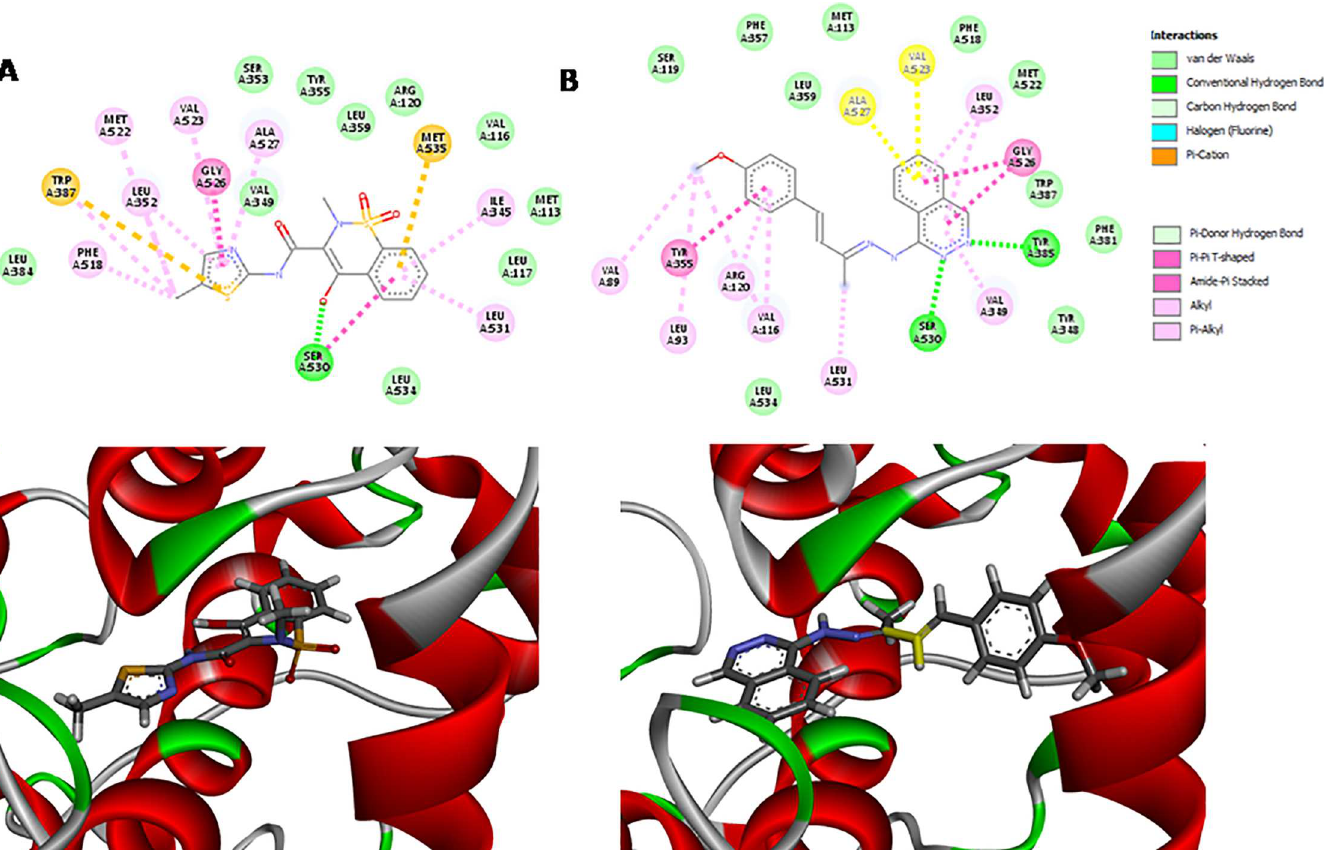
Fig 15. Results of the docking procedures for H5 and Meloxicam, (A) Interaction profile of H5 in the murine COX-2 enzyme binding site after the docking study; (B) Interaction profile Meloxicam in the murine COX-2 enzyme binding site after the redocking study.